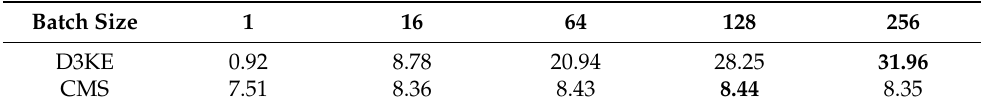
Table 5. Comparison of processing speed in FPS of D3KE and the baseline for multiple images or ’batches’ in parallel. OpenSim does show little change in processing speed for increasing batch sizes. The proposed method achieves framerate speeds for batches of 256 images, allowing it to analyze images as fast as a common webcam or mobile phone camera collects them. Bold numbers indicate